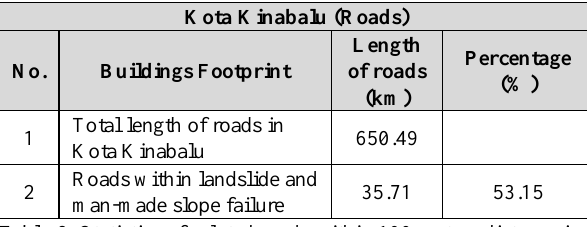
Table 6. Statistics of selcted roads within 100 meters distance in